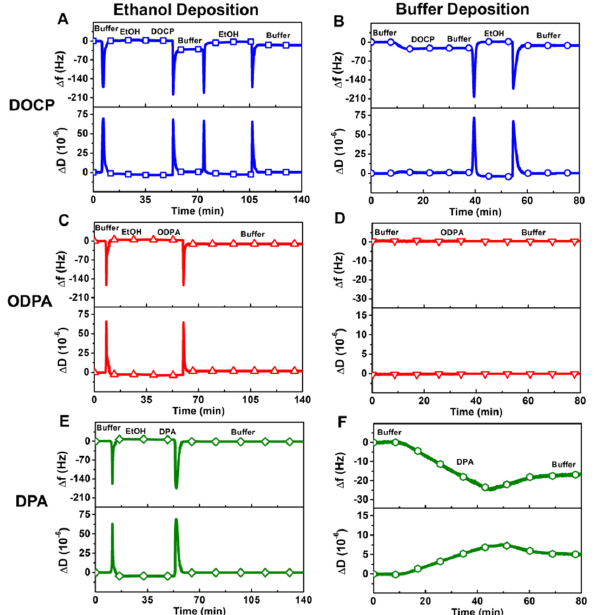
Figure 2. Real-time QCM-D tracking of molecular deposition processes on TiO 2 surface in different solvent systems. Time-resolved ∆ f and ∆ D signals are reported for DOCP attachment in ( A ) ethanol and ( B ) buffer. Corresponding data for ( C , D ) ODPA and ( E , F ) DPA. In all cases, a buffer baseline step was initially established, and subsequent steps labeled as EtOH and buffer refer to ethanol and buffer washing steps, respectively.